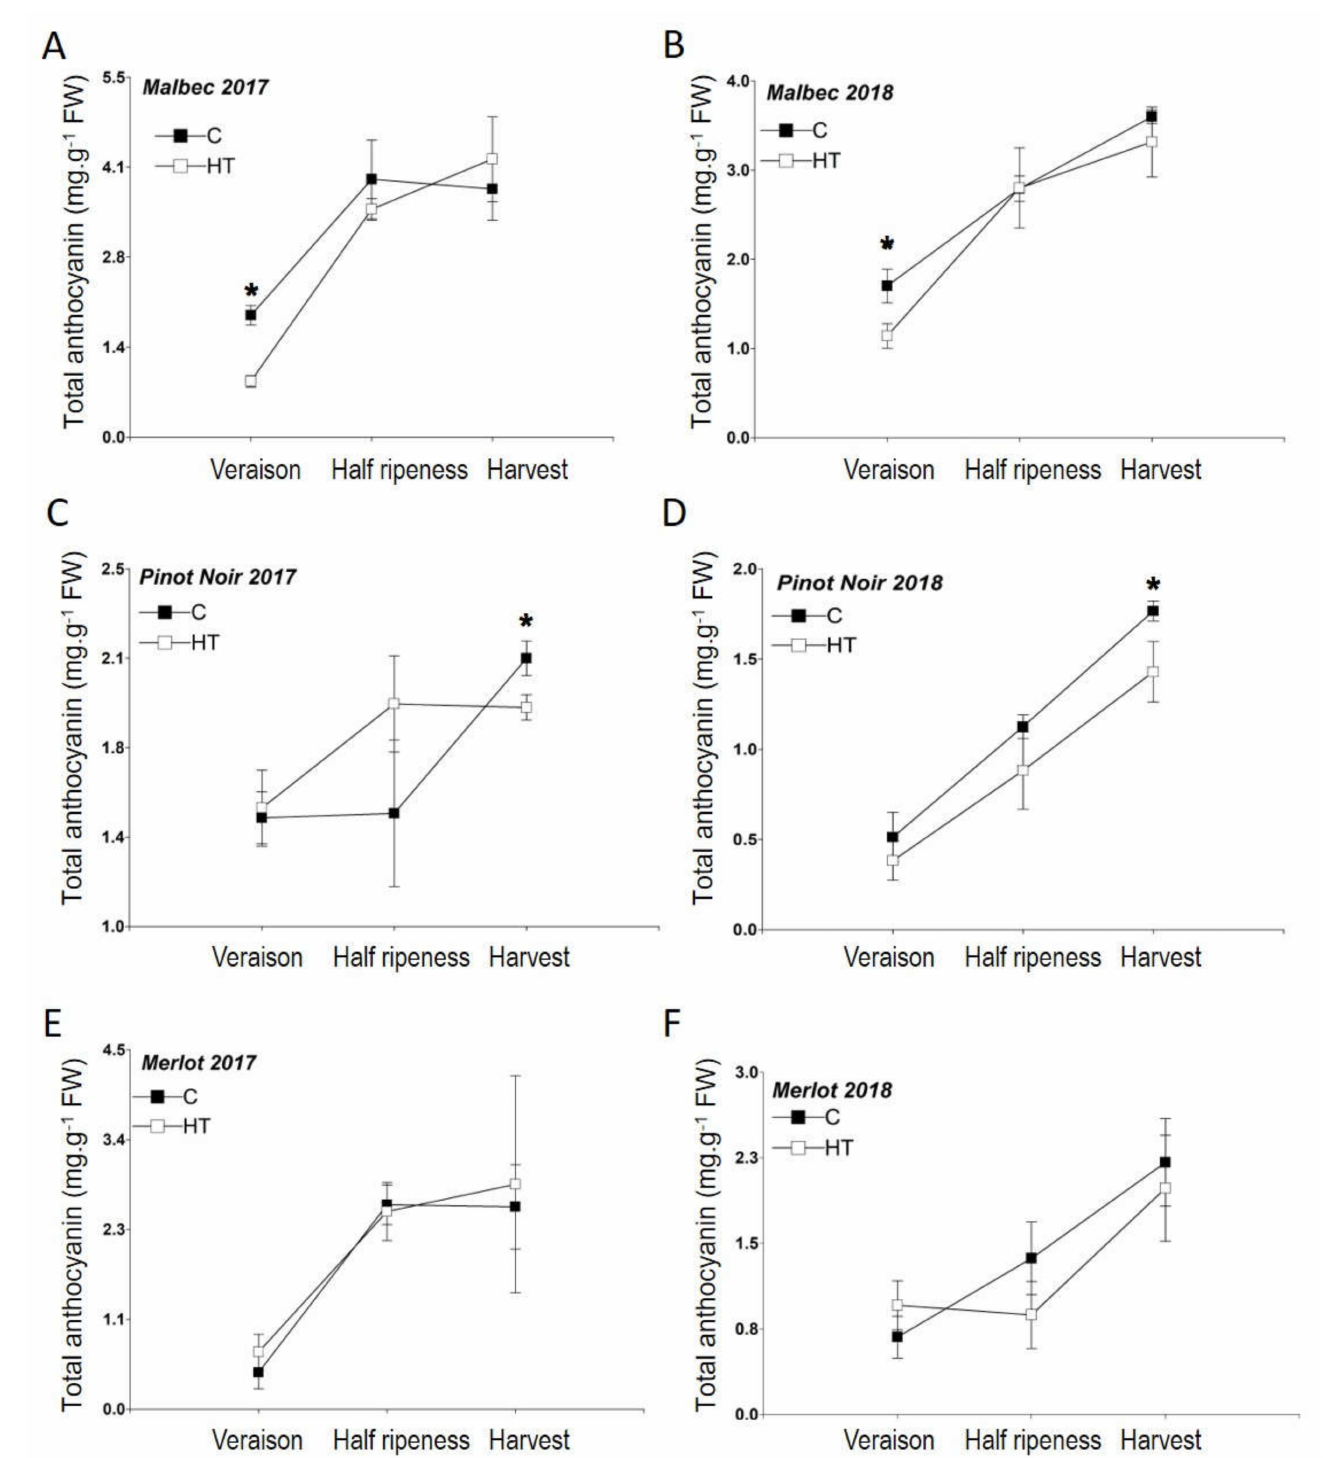
Figure 2. Total anthocyanin concentration in berries of Malbec ( A , B ), Pinot Noir ( C , D ), and Merlot ( E , F ) plants grown under increased temperature (HT) and normal conditions ( C ) in 2017 and 2018. Error bars represent standard errors from four replicates. Asterisks indicate significantly different ( p < 0.05) anthocyanin concentration between HT and C treatments for a given phenological stage, according to means comparison analysis by LSD